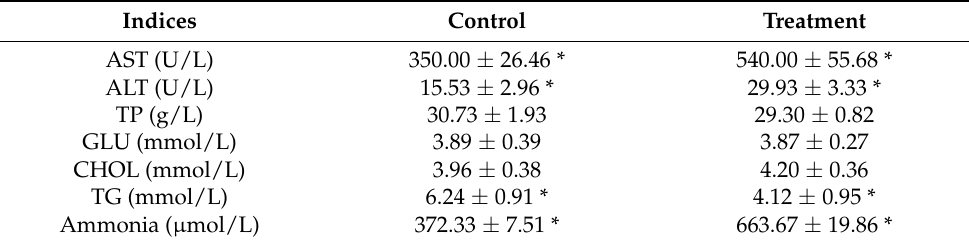
Table 8. Comparison of serum biochemical indices in A. schrenckii . Indices